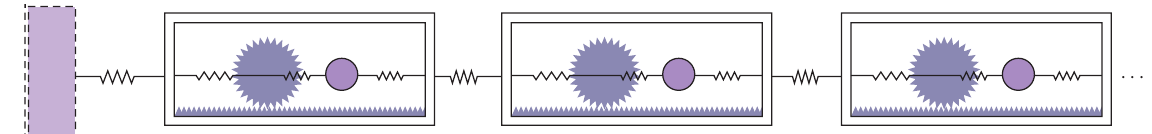
Figure 4: A schematic of the metamaterial arrangement of the 2DOF model.